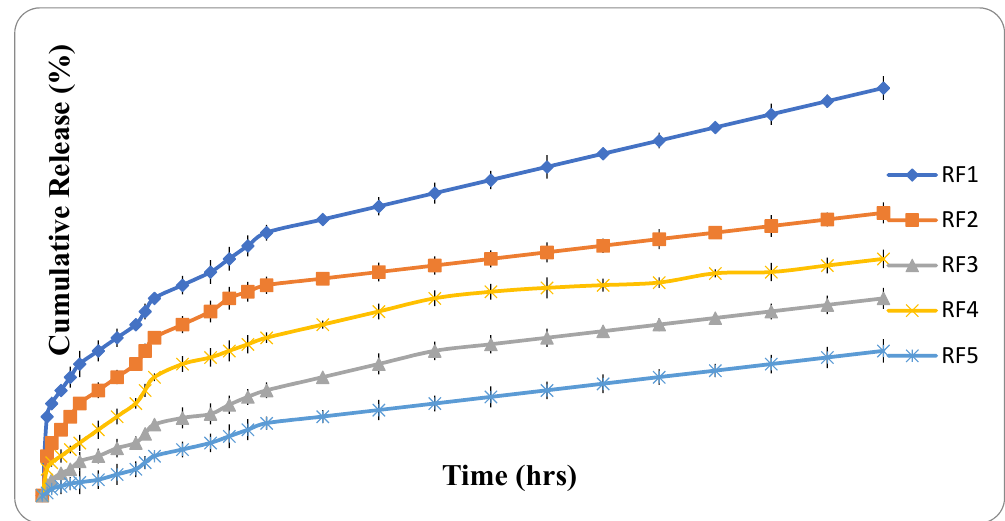
Figure 5. Bar graphs of different parameters (A) entrapment efficiency; (B) water uptake; (C) tensile strength (D) elongation to break (data were presented as mean ± SD and analyzed by one-way ANOVA followed by Tukey’s test as post hoc analysis. ‘a’ represents p <0.05 vs. RF1, RF2, RF3 and RF4).